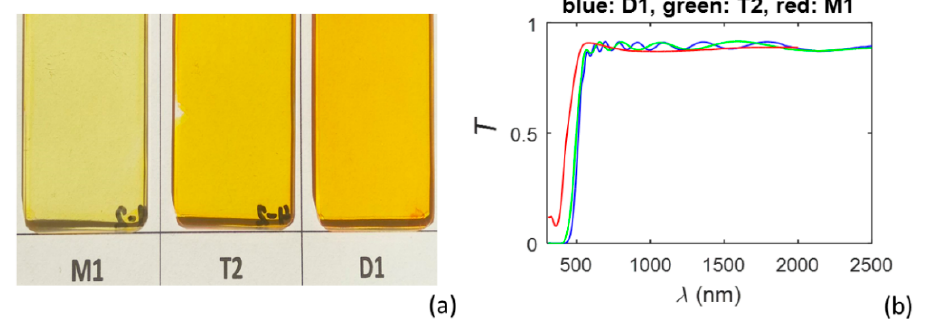
Figure 1. ( a ) Photos of the PAZO polymer samples; ( b ) Measured transmittance spectra of these samples.